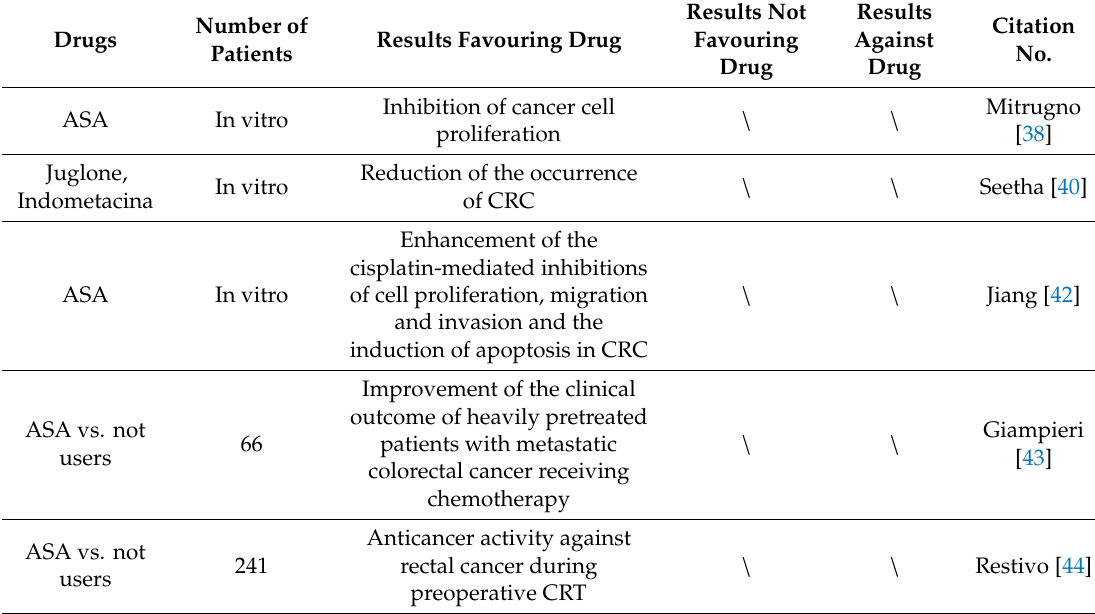
Table 2. Summary of studies for FANS / non-steroid anti-inflammatory drugs (NSAIDs) as a prognostic